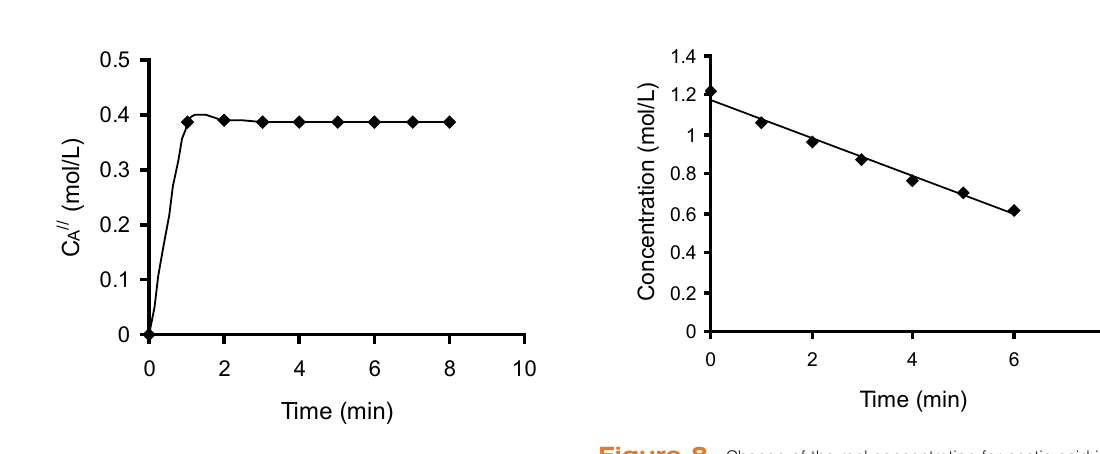
Figure 7. Concentration of absorbed acetic acid versus time.